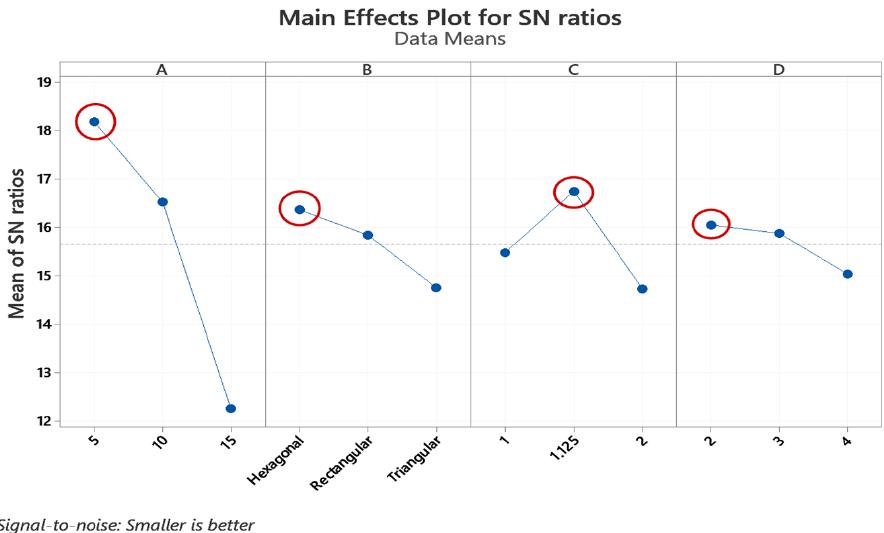
Figure 4. Main effect plot cylindricity. A, B, C, and D represent the Thickness, Infill Pattern, Layer height, and Wall Layer, respectively.